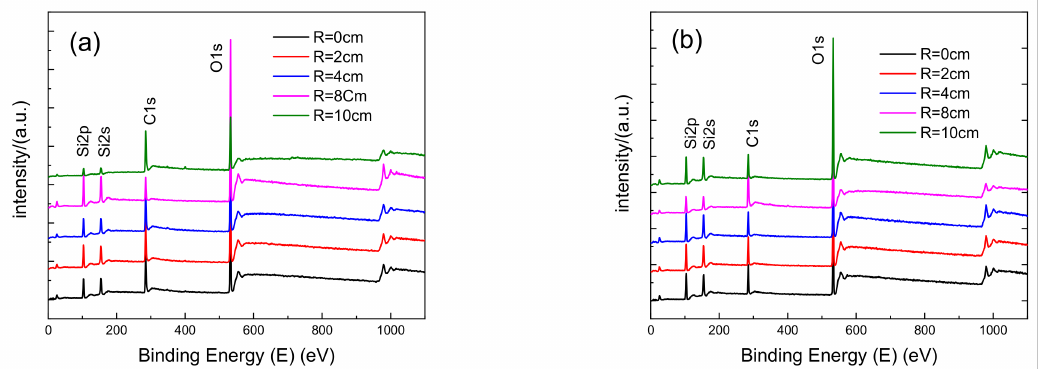
Figure 7. XPS analysis ( a ) of the upper surface, ( b ) underneath the